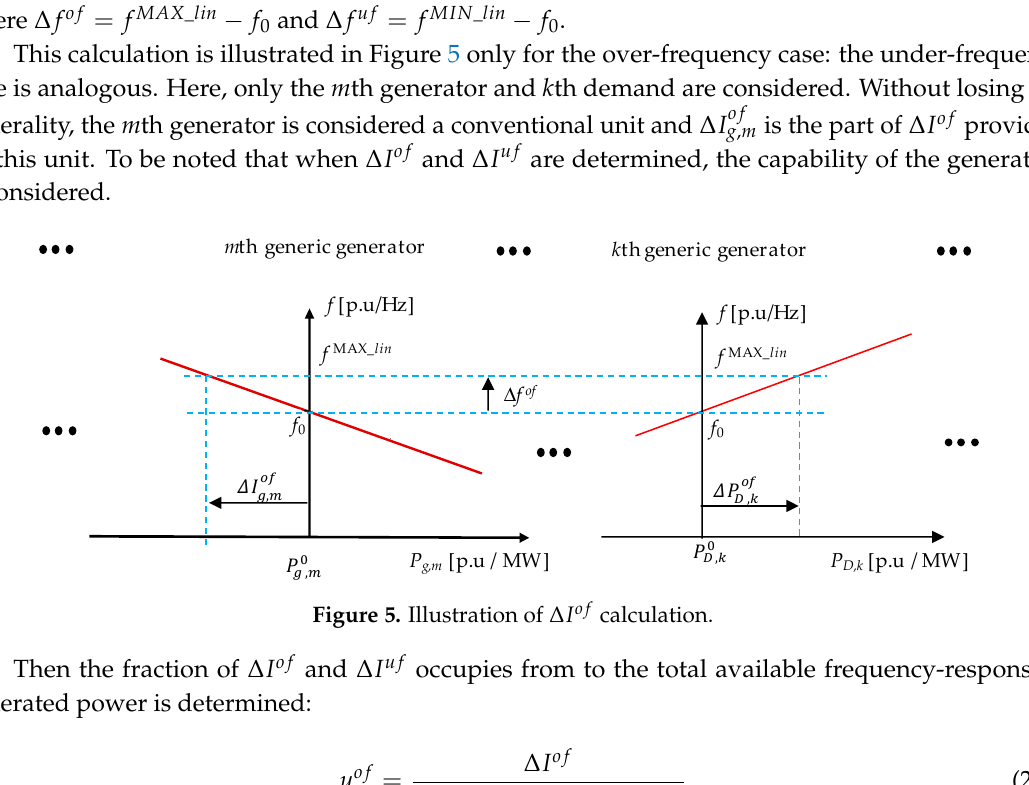
10 of 24 Figure 4. Basic flowchart of the Decomposition Model. 2.1.1. The Linear Optimization Problem The goal of this optimization problem is the same as the one of the Base Problem, therefore the same OF Equation (8) is used. The difference stands in the formulation of the constraints. In the base problem the non-linearity is given by the set of Equation (11) which are required to explicitly calculate the final real power and network’s frequency in islanding conditions. Here, a simplified constraint is designed to implicitly consider this aspect and neglect the variables and constraints associated with the explicit calculation (the ones with superscript “1”). In order to clearly understand, the new constraint is explained in few logical steps. First, a minimum and maximum frequency limits are defined, i.e., 𝑓 (cid:3014)(cid:3002)(cid:3025)_(cid:3039)(cid:3036)(cid:3041) and 𝑓 (cid:3014)(cid:3010)(cid:3015)_(cid:3039)(cid:3036)(cid:3041) , respectively. Since the linear model represents an approximation, these limits are slightly higher than the ones used by the Base Model, i.e., 𝑓 (cid:3014)(cid:3002)(cid:3025) and 𝑓 (cid:3014)(cid:3010)(cid:3015) , respectively. Then, it is considered that no shedding action occurs during islanding and the total regulating energy of the network for over- frequency, 𝑒 (cid:3047)(cid:3042)(cid:3047)(cid:3042)(cid:3033) , and under-frequency, 𝑒 (cid:3047)(cid:3042)(cid:3047)(cid:3048)(cid:3033) , is calculating using Equation (17) where all 𝑌 (cid:3036) and 𝑌 (cid:3038) are considered equal to 0 and all 𝑌 (cid:3037)∗ are considered 1 for over-frequency or 0 for under-frequency (see Figure 2 or Equation (5) for clarification). Then, 𝑒 (cid:3047)(cid:3042)(cid:3047)(cid:3042)(cid:3033) and 𝑒 (cid:3047)(cid:3042)(cid:3047)(cid:3048)(cid:3033) are used in combination with Equation (4) to calculate the theoretical imbalance the network’s power plants should compensate, i.e., Δ𝐼 (cid:3042)(cid:3033) and Δ𝐼 (cid:3048)(cid:3033) , respectively, in order to bring the frequency at 𝑓 (cid:3014)(cid:3002)(cid:3025)_(cid:3039)(cid:3036)(cid:3041) and 𝑓 (cid:3014)(cid:3010)(cid:3015)_(cid:3039)(cid:3036)(cid:3041) ,